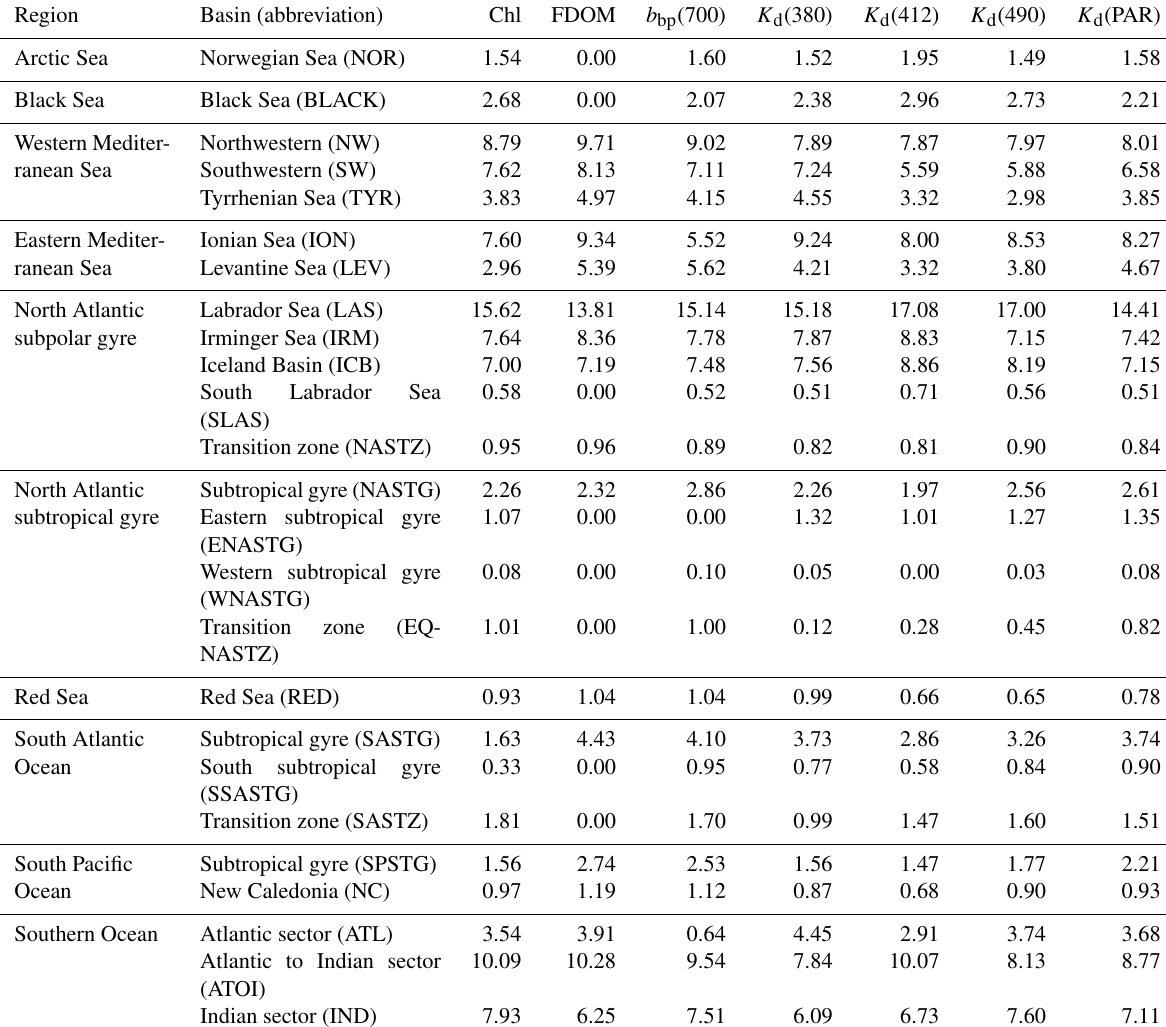
Table 2. Relative contribution (%) of biogeochemical and bio-optical variables for the 25 geographic regions included in the Biogeochemical- Argo database within the first optical depth